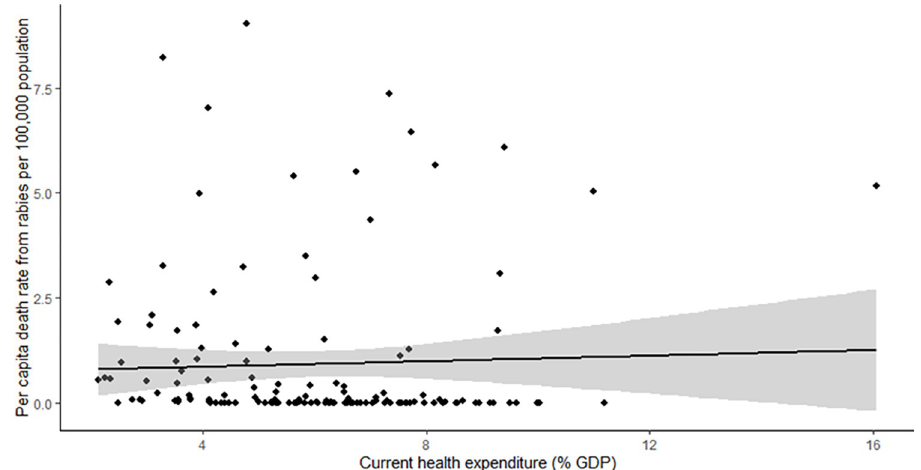
Fig 2. Results from Linear Regression with Poisson distribution, showing the relationship between current health expenditure (% GDP) from 2020, and per capita death rate from rabies per 100,000 population from 2015 for 146 countries where data were